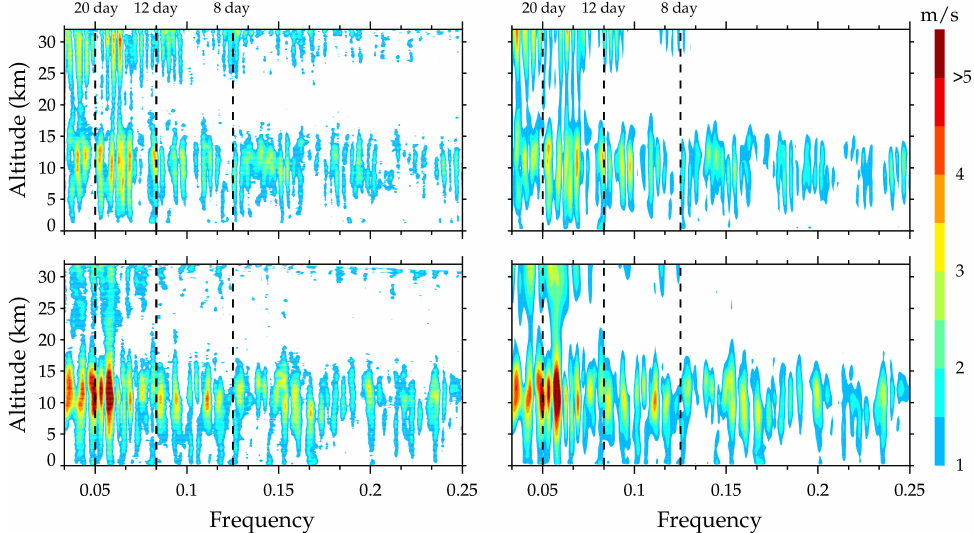
Figure 2. Lomb–Scargle periodograms of the zonal winds at Santa Teresa ( top row ) and Perth Airport ( bottom row ) deduced from the radiosonde observations ( left panels ) and MERRA-2 data ( right panels ) in 2020. The three dashed vertical lines denote three periods of 20, 12 and 8